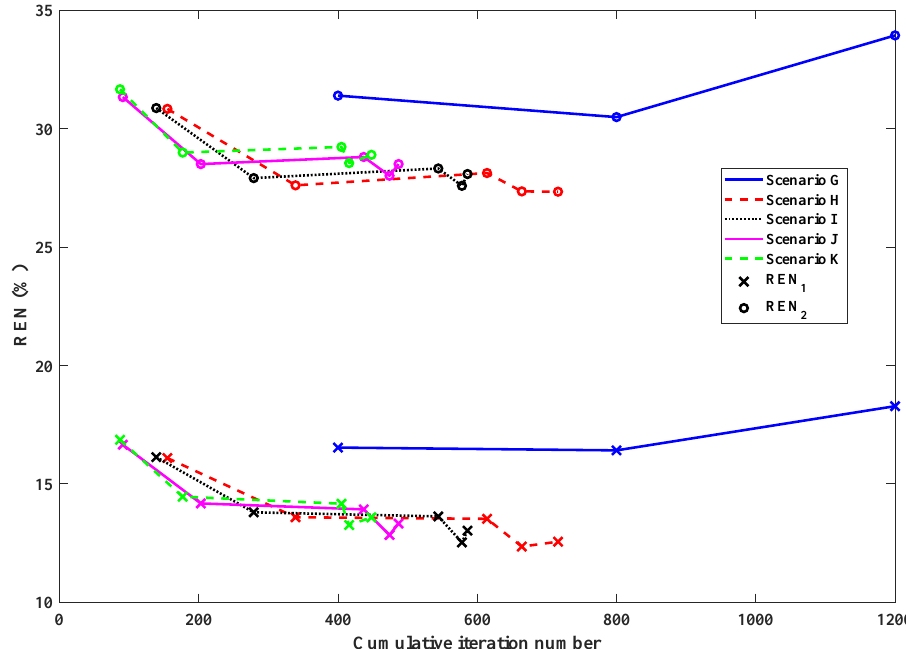
Figure 12. Relative error norms of frequency-hopping and frequency-cycled reconstructions of Category D model: Scenario G (blue solid line)—without tissue-dependent mapping at 400 iterations per frequency terminating after first inversion of 3.0 GHz (5% noise), Scenario H (red dashed line)—with tissue-dependent mapping and stopping criteria in place at 3% noise, Scenario I (black dotted line)—with tissue-dependent mapping and stopping criteria in place at 5% noise, Scenario J (magenta solid line)—with tissue-dependent mapping and stopping criteria in place at 7.5% noise, Scenario K (green dashed line)—with tissue-dependent mapping and stopping criteria in place at 10% noise.